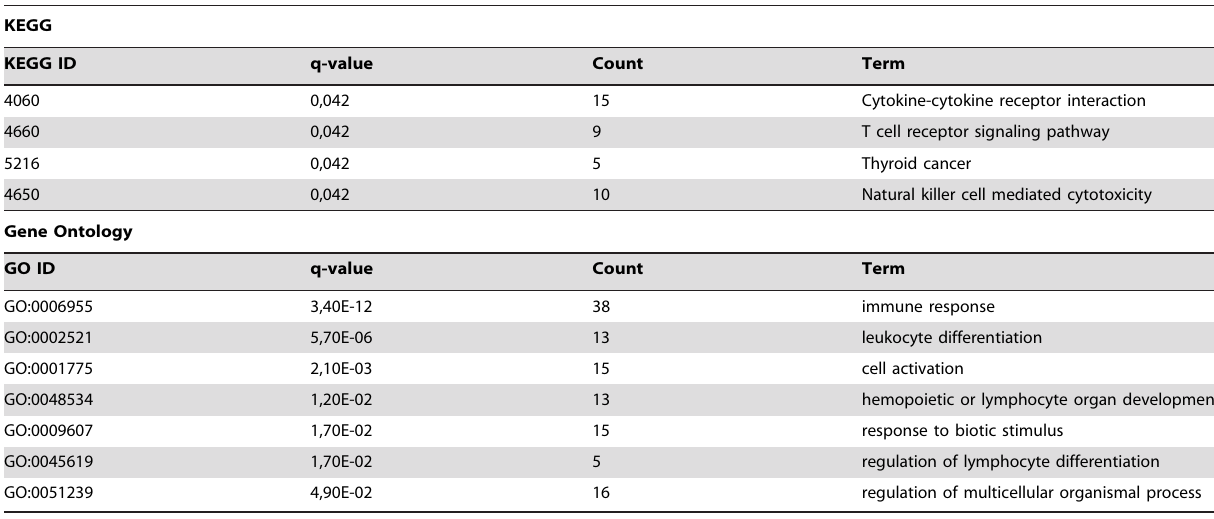
Table 2. Enrichment analysis between patients with aggregates or